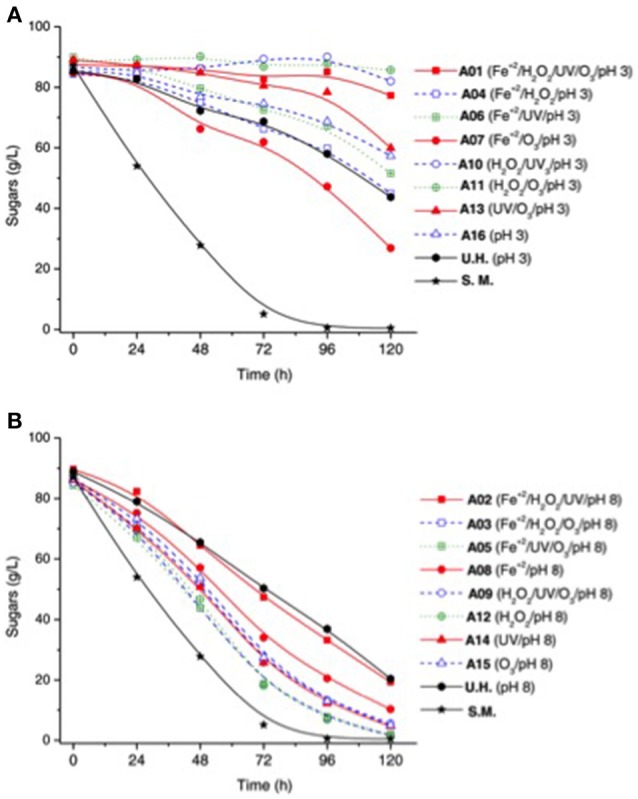
Sugar consumption by Pichia stipites in the hydrolysate treated in different conditions of experimental design. Sugar consumption during the fermentations by P. stipitis in semi-synthetic medium (S.M.), untreated rice straw hemicellulosic hydrolysate (U.H.) and the hydrolysate treated by AOPs homogeneous under different conditions of the experimental design, where: (A) treatments performed at pH 3, (B) treatments performed at pH 8. The standard deviation was <5% of the mean values of sugars consumption (Reproduced from Silva et al., 2013).